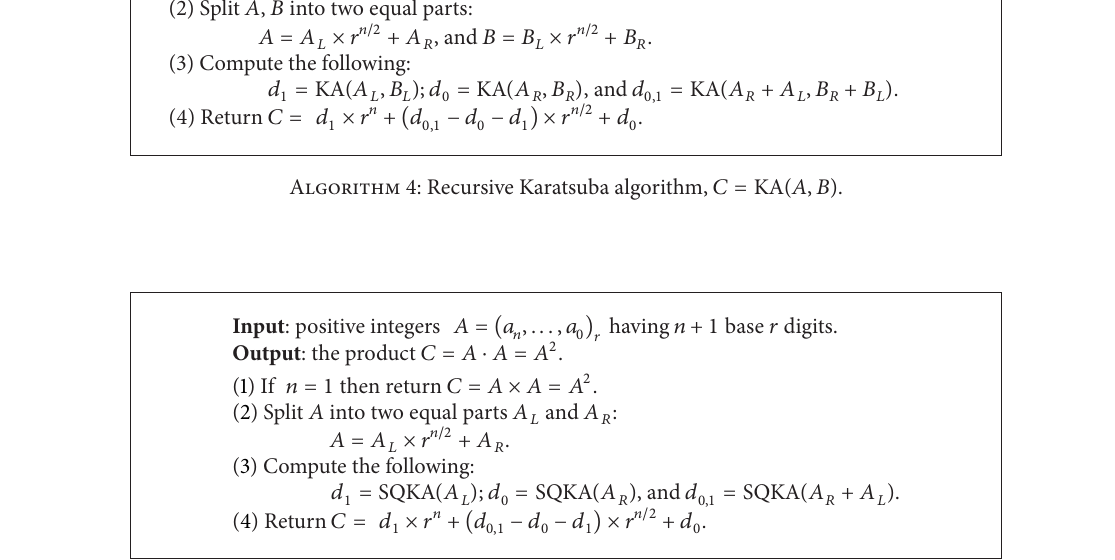
Algorithm 5: Recursive Karatsuba squaring algorithm, 𝐶 = SQKA (𝐴)